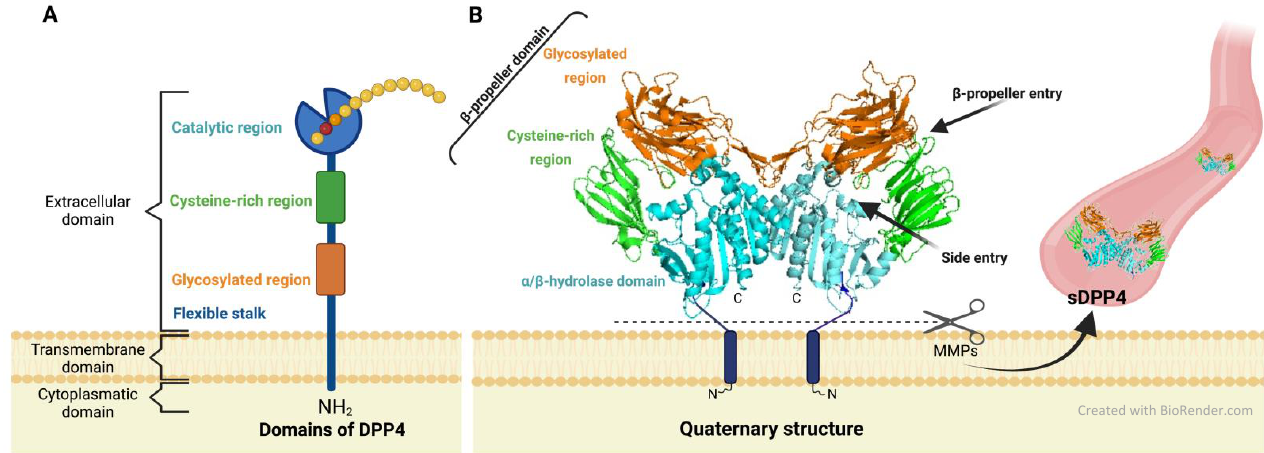
Figure 1. DPP4 structure. ( A ) Schematic representation of the DPP4 primary structure. The glycosylated region is shown in orange, the cysteine-rich region in green, and the catalytic region in blue. ( B ) Quaternary structure of the DPP4 homodimer. Metalloproteases (MMPs) are represented by a grey scissor, and after digestion, the soluble form of DPP4 (sDPP4) sheds from the membrane, releasing into biological fluids, such as the bloodstream (on the right).